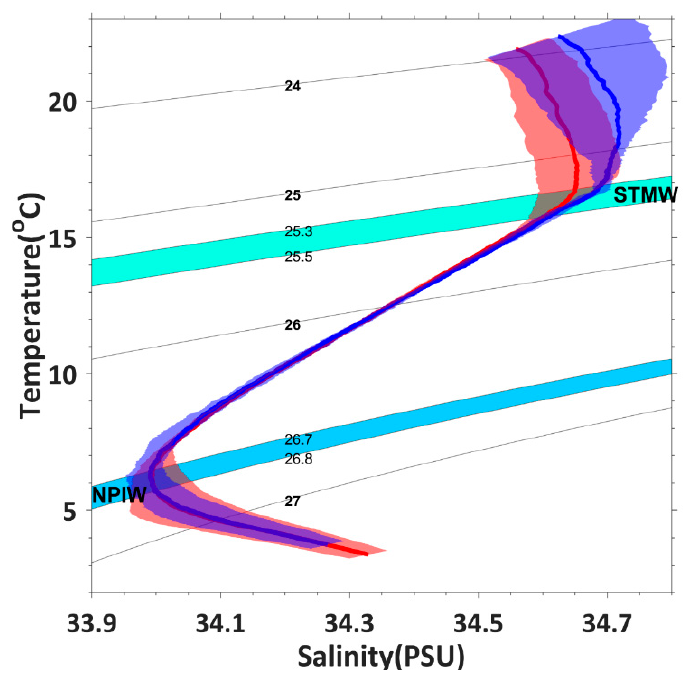
Figure 11. Temperature-Salinity diagram. The blue and red lines are the averages of temperature and salinity inside and outside the eddy. The shaded regions are their standard deviations, respectively. The STMW and NPIW are cyan and blue color shaded, which correspond to 25.3 𝜎 (cid:3087) -25.5 𝜎 (cid:3087) and 26.7 𝜎 (cid:3087) -26.8 𝜎 (cid:3087) , respectively.